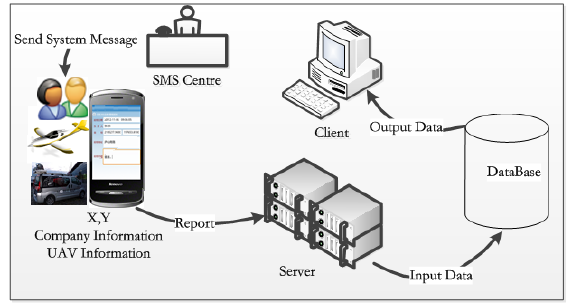
Figure 1: UAV tracking